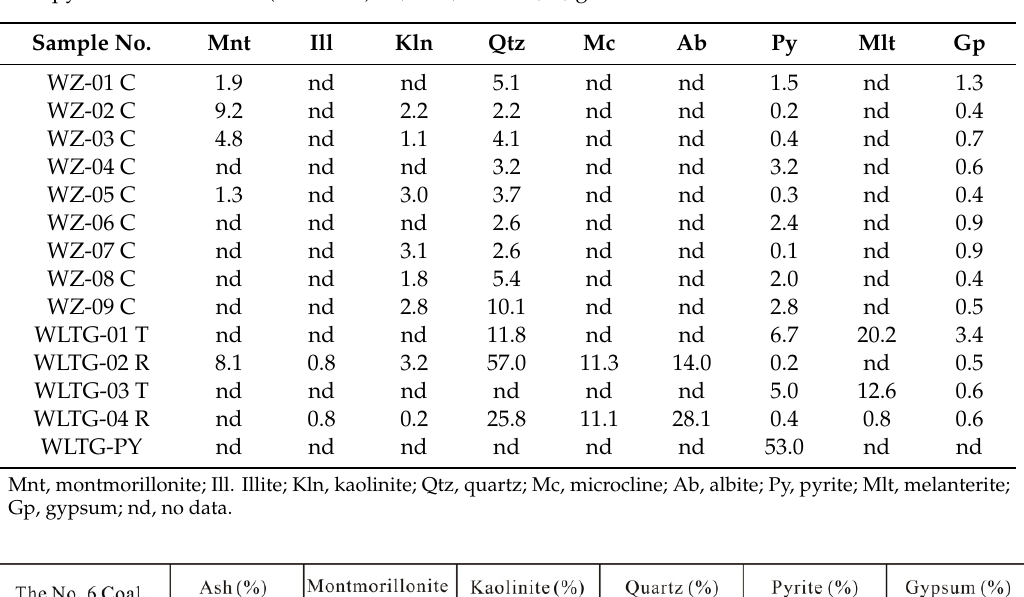
Table 3. Semi-quantitative mineral composition of the studied coals, coalified trunks, roof glutenites, and pyrite mineralization (wt. % db). C, coal, T trunk, R, glutinite-roof. Sample No. Mnt Ill Kln Qtz Mc Ab Py Mlt WZ-01 C